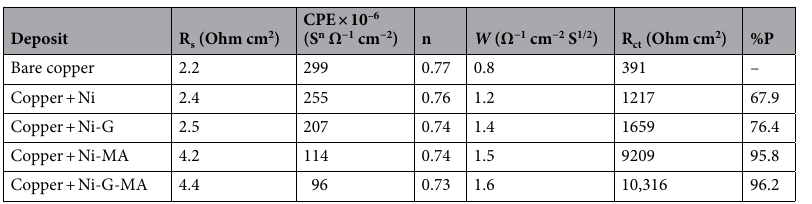
Table 2. Electrochemical impedance spectroscopy parameters for bare and coated copper by Ni, Ni-G, Ni-MA, and Ni-G-MA in 0.5 M NaCl solution.